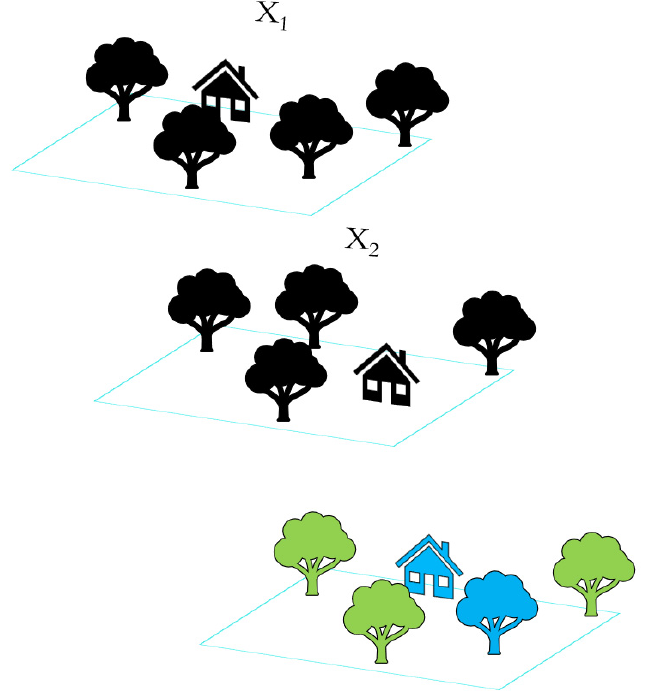
Figure 4. The clustering principle of intersections (green) and differences (blue) for two datasets, X 1 and X 2 .